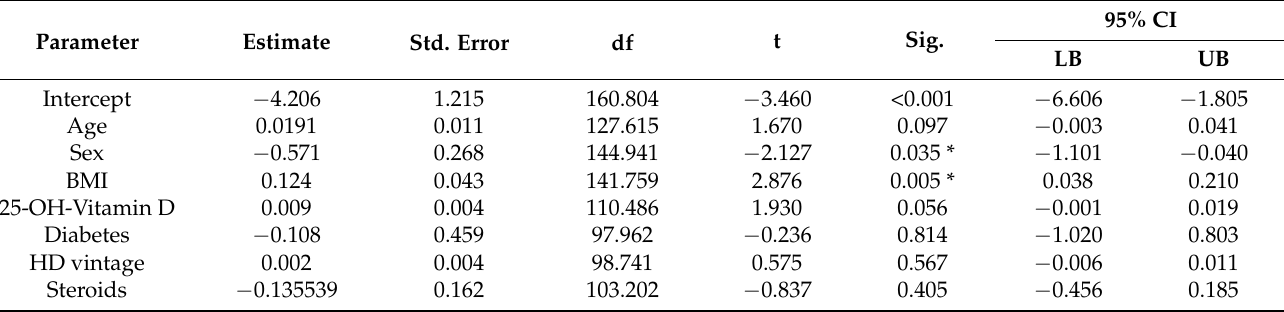
Table 5. Mixed model effect of inactive vitamin D on Z-score in kidney transplant patients at right femoral neck.